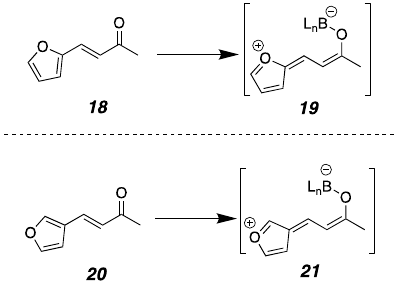
Figure 4. Resonance stabilization of Lewis acid/base interactions.